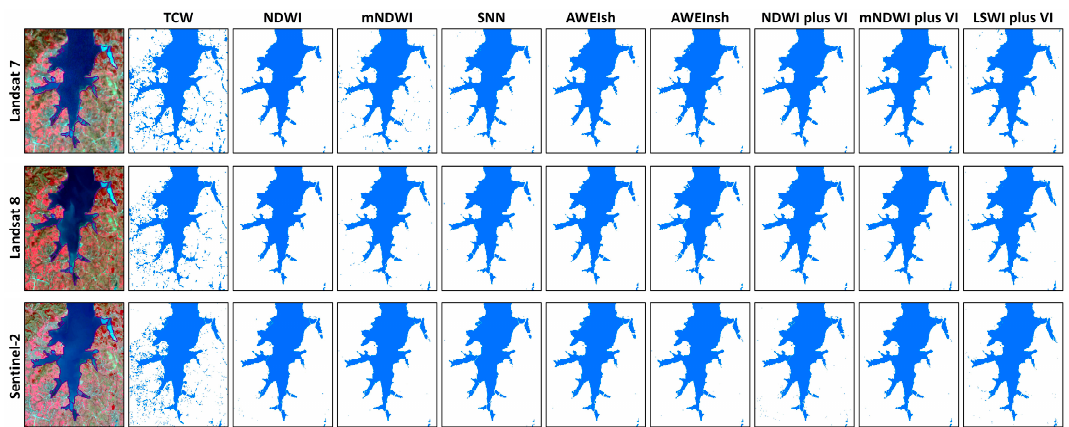
Figure 8. Contrast of the water body mapping results in the border area between the water and land from 27 combinations of the nine algorithms (refer to Table 2) and the three sensors (Landsat 7 ETM+, Landsat 8 OLI, and Sentinel-2 MSI).